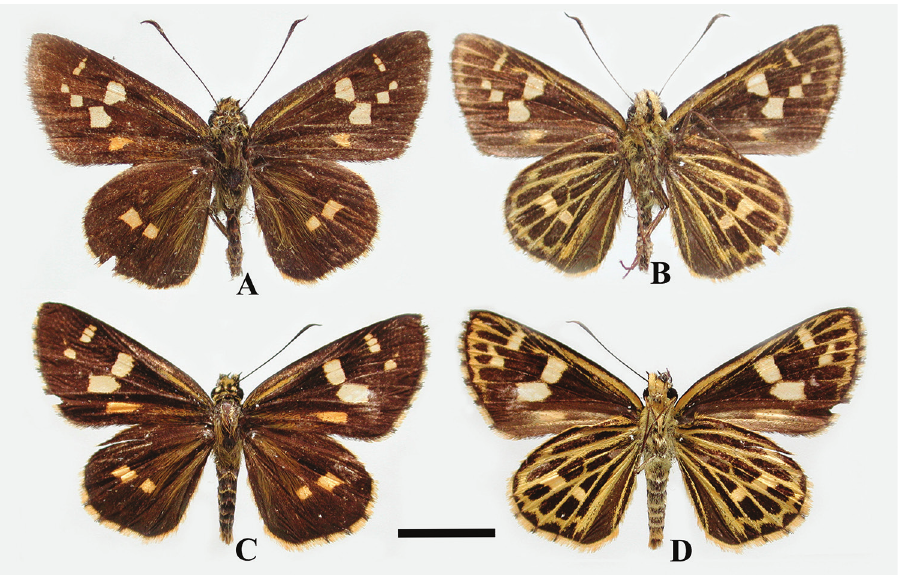
Figure 3. Scobura masutaroi Sugiyama, 1996 (Sichuan): A, B male C, D female; scale bar 10